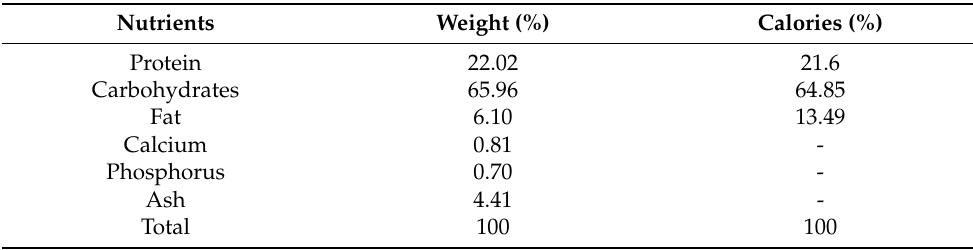
Table 1. Nutritional composition of rodent